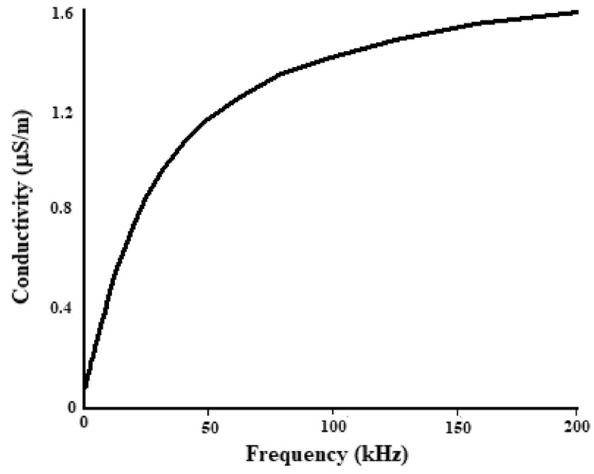
Figure 5. The change in AC conductivity with frequency at normal temperature (25°).